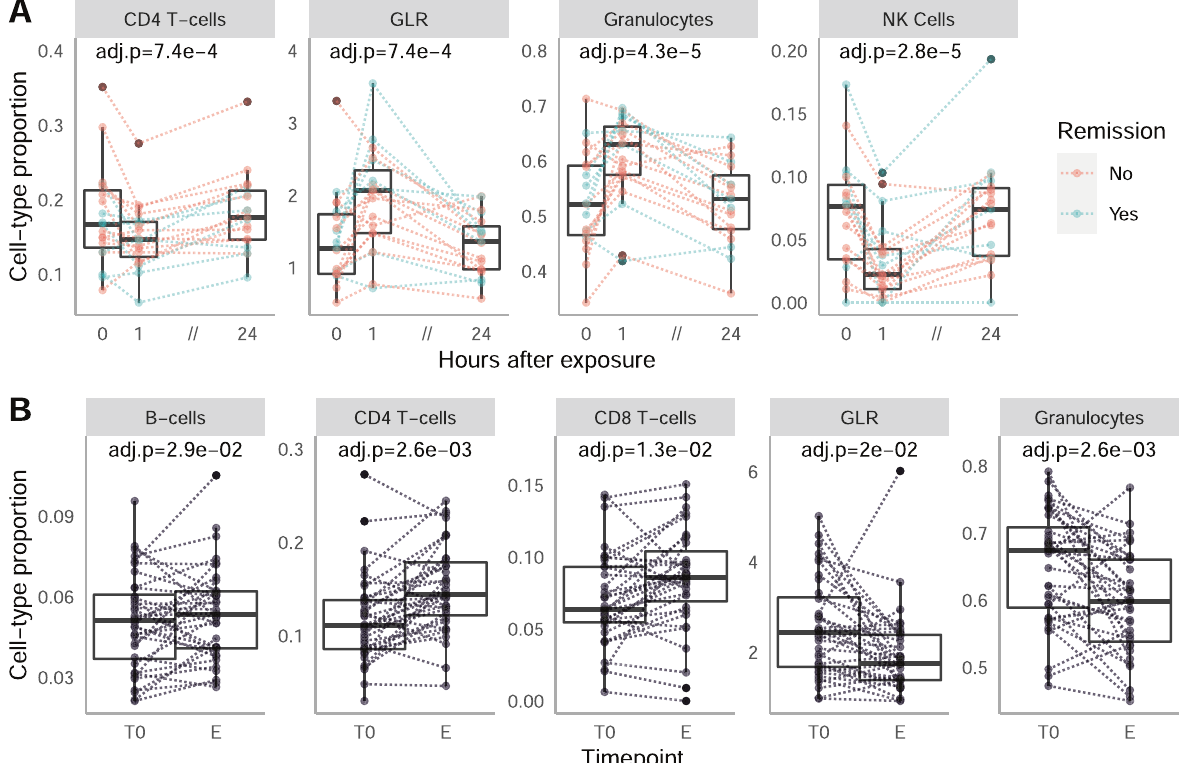
Fig. 2 Changes in White blood cells during exposure and therapy. A . Regulation of CD4 + T-cells (left), Granulocytes (middle) and Natural Killer cells (right) during the exposure phase. Thicker lines represent the mean for the remitters (blue) and non-remitters (red). The adjusted p values are reported for the effect of Time in the selected LMM (see “ Methods ” ). B . Regulation of CD4 + T-cells, CD8 + T-cells, B-cells, Granulocytes and of the granulocytes-to-lymphocyte ratio (GLR) during the course of therapy. Cell-types proportions were directly